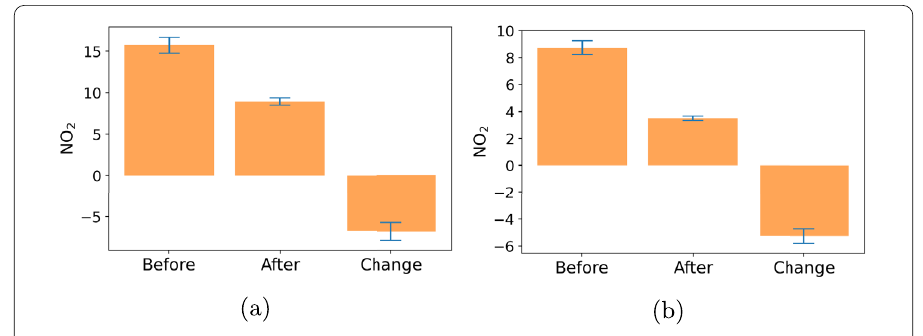
Figure 7 Averaged and change of nitrogen dioxide levels before and after Mar. 21, 2020. ( a ) For Manhattan, ( b ) For San